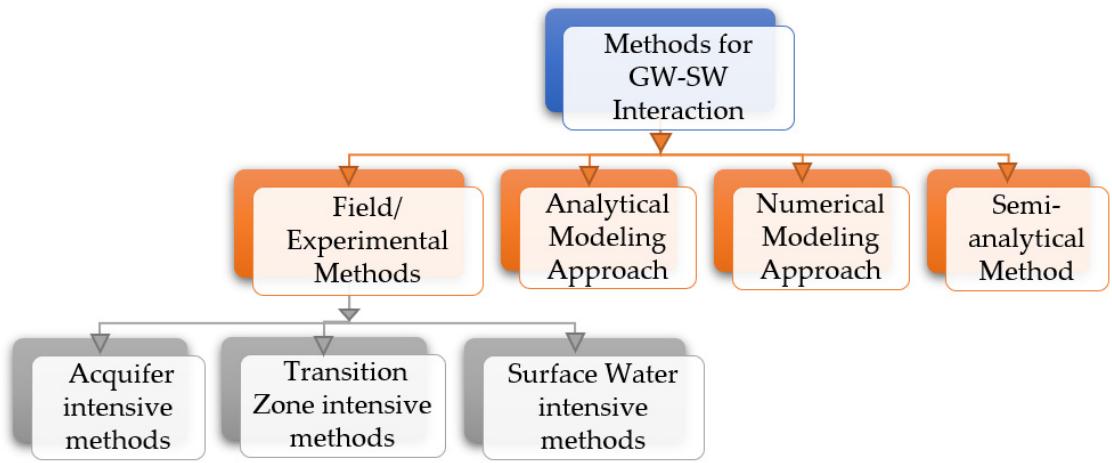
Figure 7. Methods for analyzing groundwater (GW) and surface water (SW) interactions.